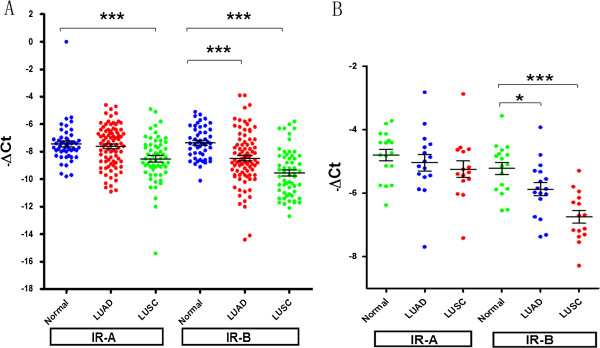
TaqMan qRT-PCR confirmation of relative mRNA Expression Levels for IR-A and IR-B in NSCLC primary tumors run on cDNA arrays. TaqMan gene expression assays determined the relative mRNA expression levels of IR-A and IR-B. For each sample, the expression levels of IR-A and IR-B were normalized to the average expression levels of 3 housekeeping genes (ACTB, GAPDH and UBC). The relative expression levels of IR-A and IR-B are represented by -ΔCt, where -ΔCt = − [(Ct of a gene of interest) - (Average Ct of 3 housekeeping genes)]. The error bars represent the mean -ΔCt ± 95% CI within a particular gene target and sample-type combination. (A): data from cDNA array, (B) data from primary tumor samples. Asterisks indicate statistically significant differences (* = P < 0.05; ** = P < 0.01; *** = P < 0.001).